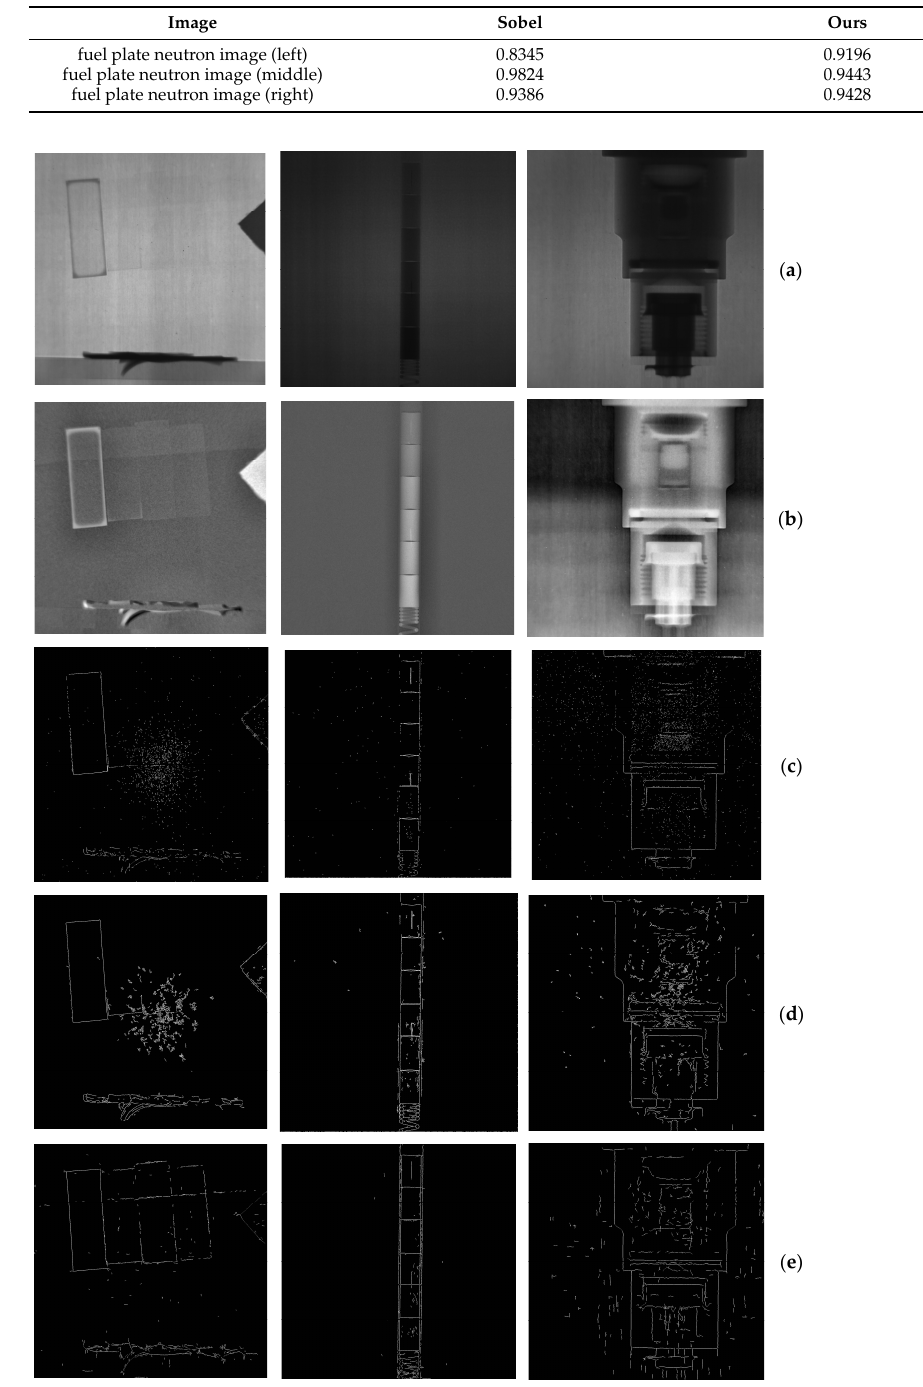
Figure 7. Edge extraction results of three different materials’ neutron images: ( a ) original images; ( b ) preprocessed images; ( c ) Sobel; ( d ) Canny; ( e ) proposed method. Table 4. Result of edge evaluation method based on connection component for three di ff erent ma- terials neutron images. Image and Method